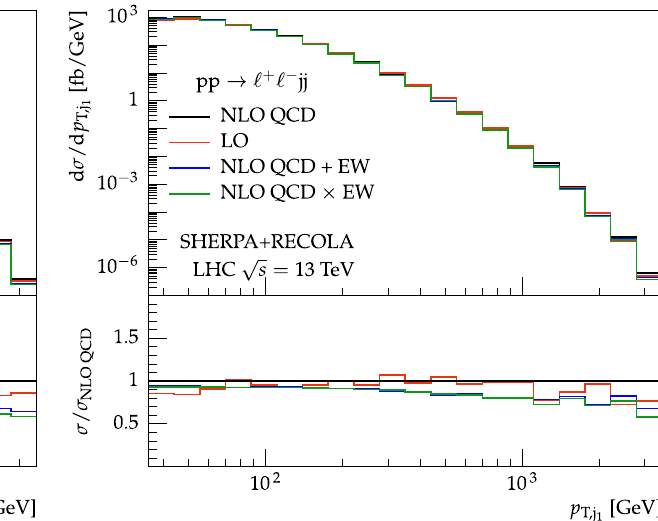
and multiplicative (NLO QCD × EW) prescriptions for combining the NLO corrections. The ratio of the distributions with respect to NLO QCD is presented in the lower panels